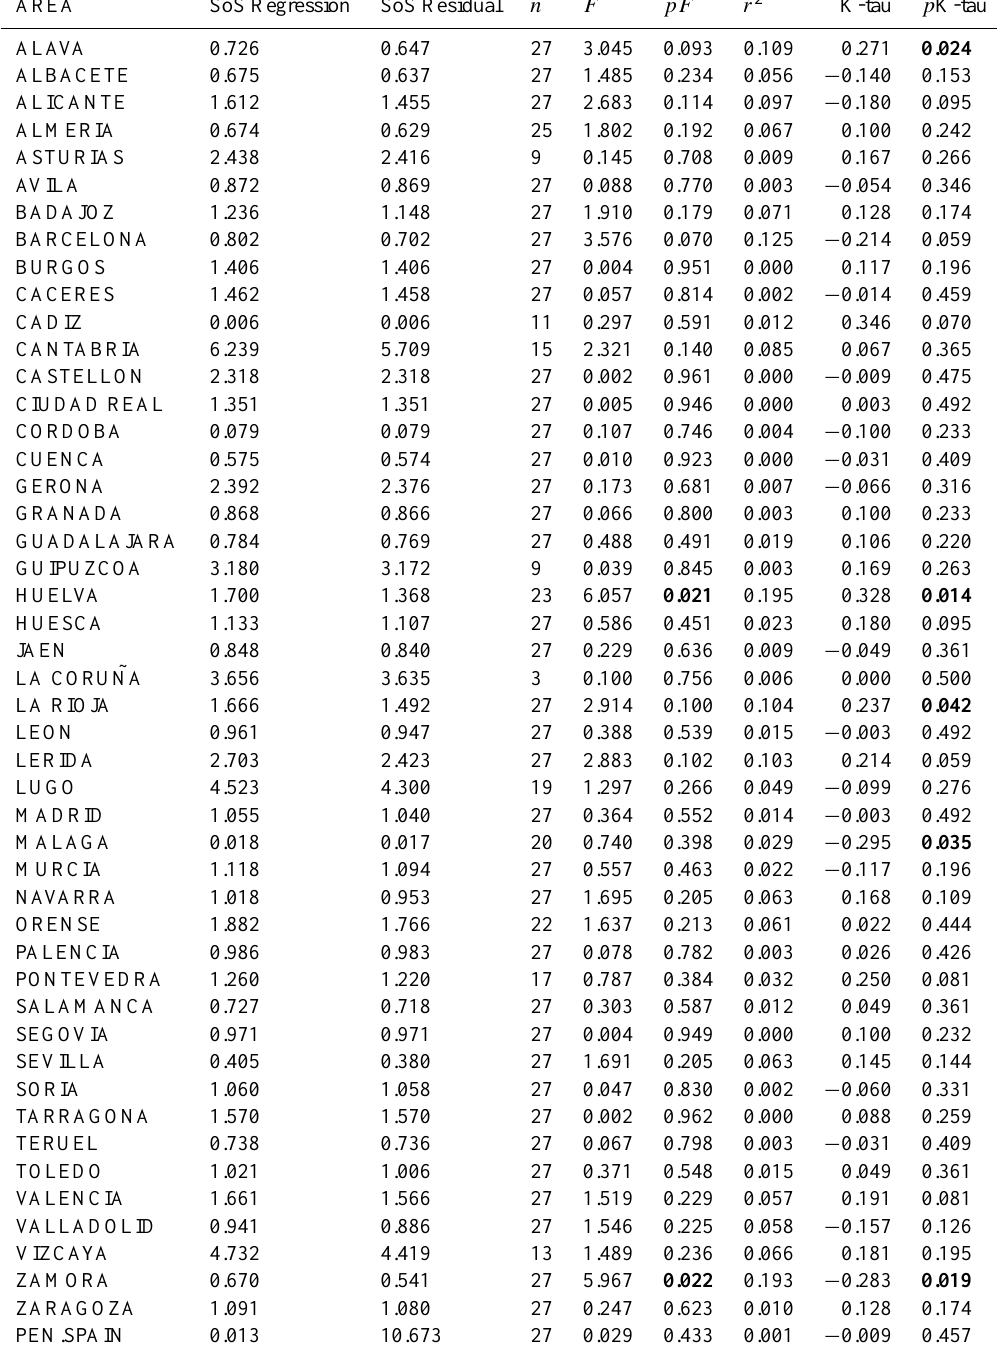
Table 1. Lineal correlations statistical parameters: Pearson r and Kendall tau. Forty-seven provinces and the Peninsular Spain as a single set (PEN. SPAIN) are shown. (SoS = Sum of squares; n = number of data; F = F test parameter; pF = probability of F ; r 2 = correlation coef- ficient; K-tau = kendall’s tau parameter; p K-tau = probability of K-tau). pF bold numbers correspond to 5% significant Pearson correlation coefficients. p K-tau bold numbers correspond to 5% significant